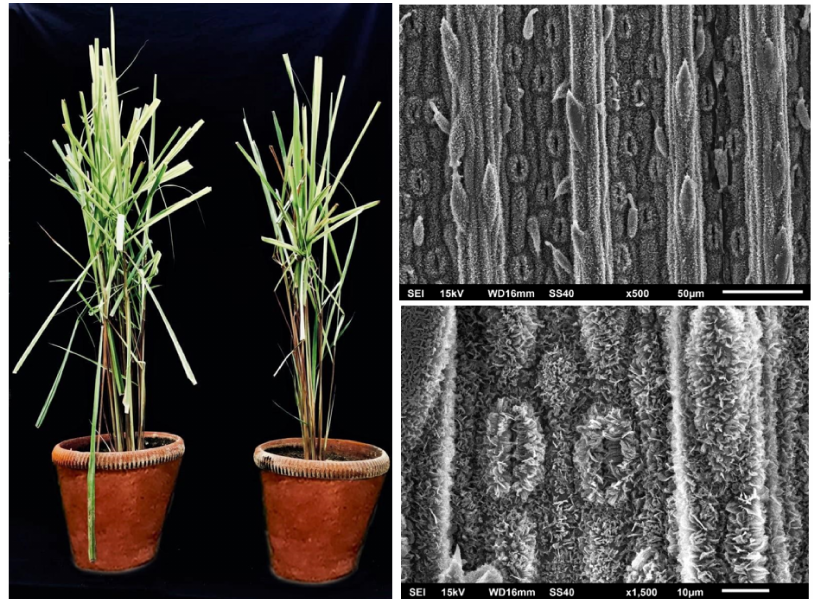
Figure 1. Morphological and anatomical profile of lemongrass ( Cymbopogon flexuosus (Steud.) Wats) plants. The morphological representation of 150-days-old healthy lemongrass plants. Scanning electron microscopy (SEM) analysis of lemongrass leaf visualizing trichomes at × 500 magnification, stomatal characteristics at × 1500 magnification and Images provided by Mukarram’s